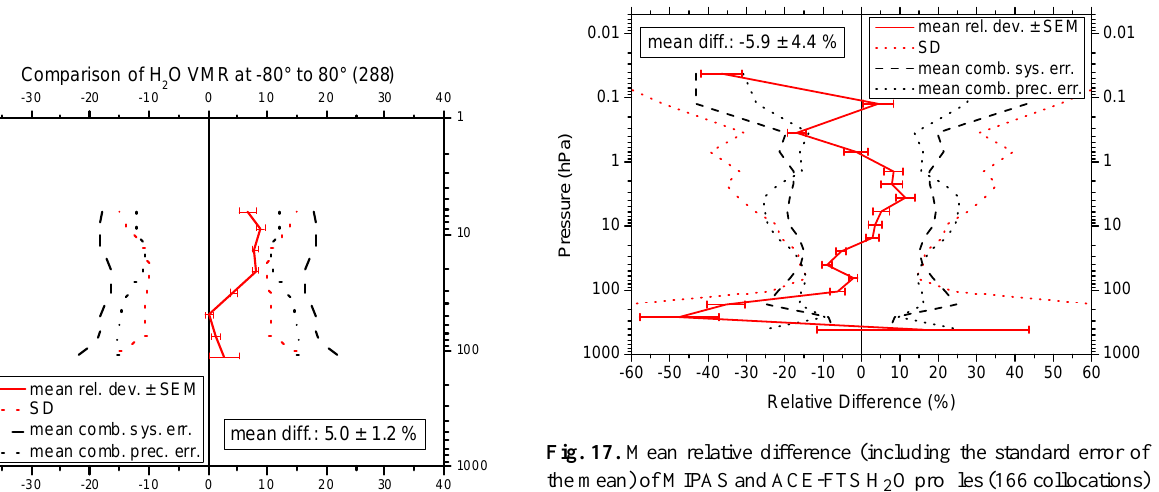
Fig. 15. Mean relative deviation (including the standard error of the mean) of H 2 O profiles as measured by MIPAS and SAGE II in the Northern (left) and Southern (right) Hemispheres for different latitude regions from 60–80 ◦ N (top left), 30–60 ◦ N (bottom left), 28–60 ◦ S (bottom right), and 60–80 ◦ S (top right). Annotation as per Fig. 13.